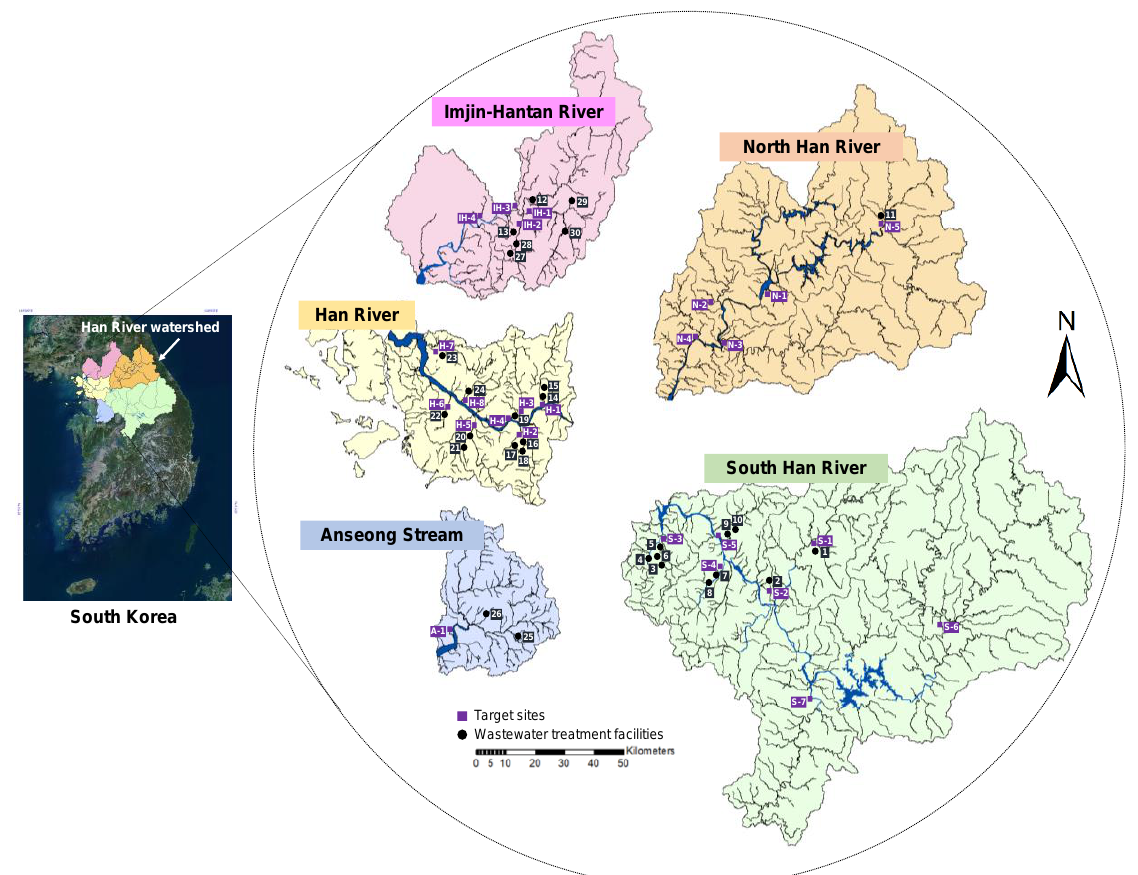
Figure 1. Location of Han River watershed in the South Korea showing the sampling sites and wastewater treatment facilities (WTFs).